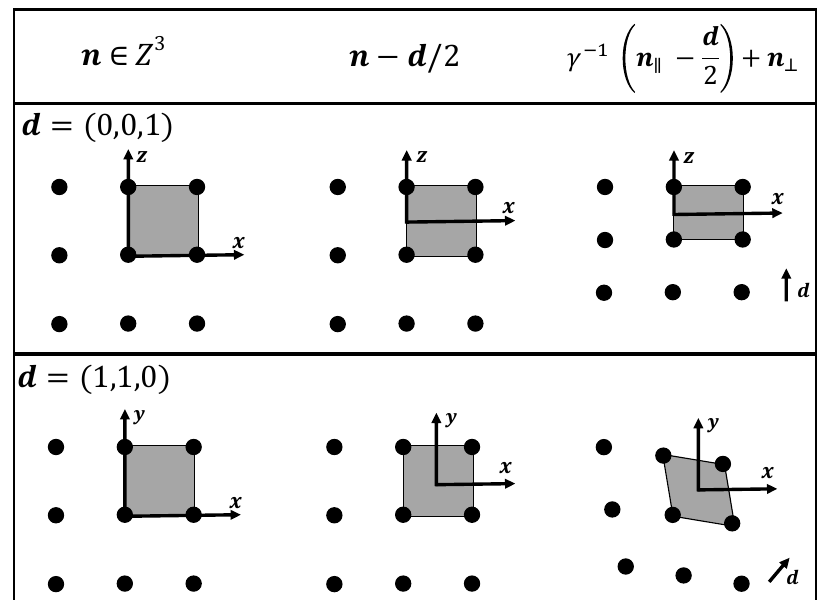
Figure 1 . Meshes of the set of discrete momenta for a two-particle system with equal masses in the BF (left column) and CMF (right column). The second and third meshes in each row illustrate the shift of the origin by d / 2 and the deformation in the direction of d to obtain the mesh in the